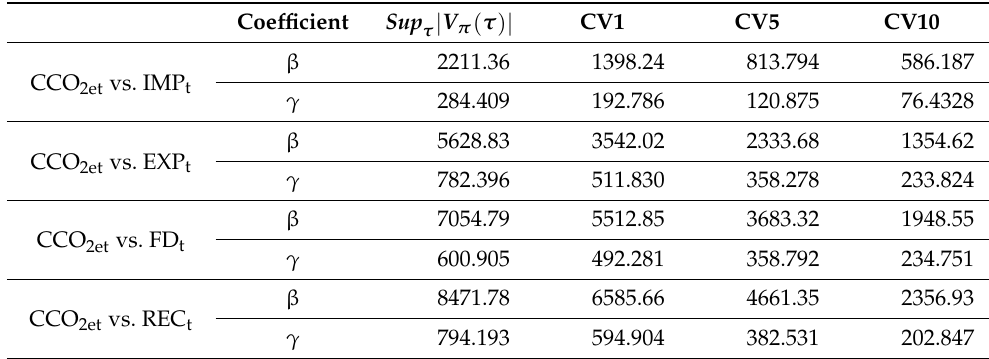
Table 5. Quantile cointegration test